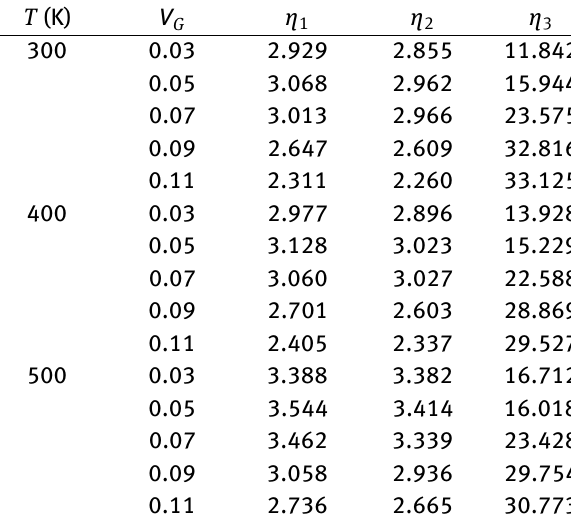
Table 2: Temperature dependent eflciency parameters of graphene/PMMA nanocomposites